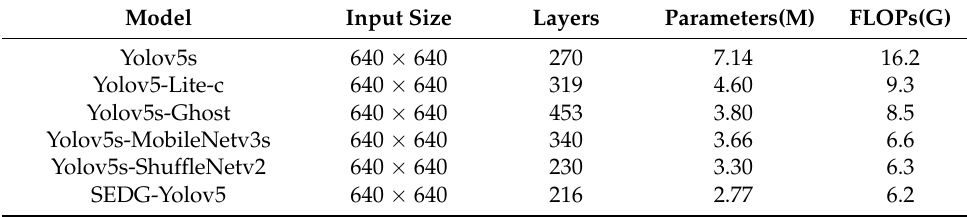
Table 1. Performance comparison of different lightweight models with our proposed